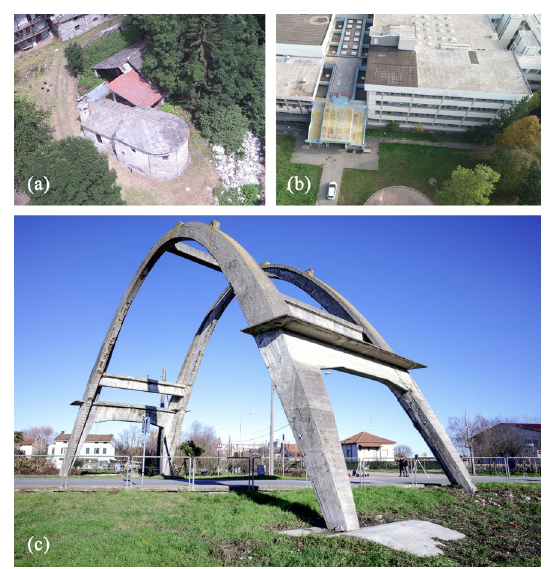
Figure 1 . Case studies: (a) the rural chapel in Molini Allioni (Elva, Cuneo); (b) C. Alvaro-P. Gobetti Comprehensive School (Torino); (c) the parabolic arch of Morano sul Po.